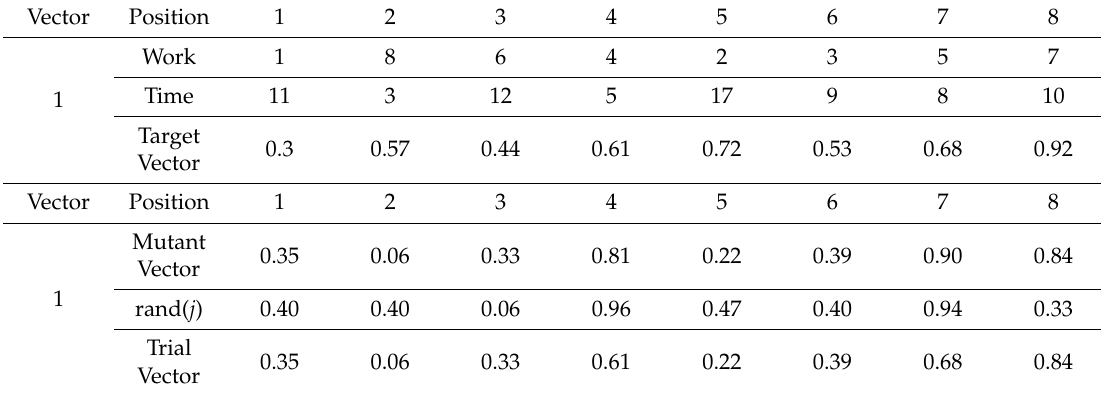
Table 3. Results of Binomial Crossover in Vector 1 with the DE/rand/1 Method.